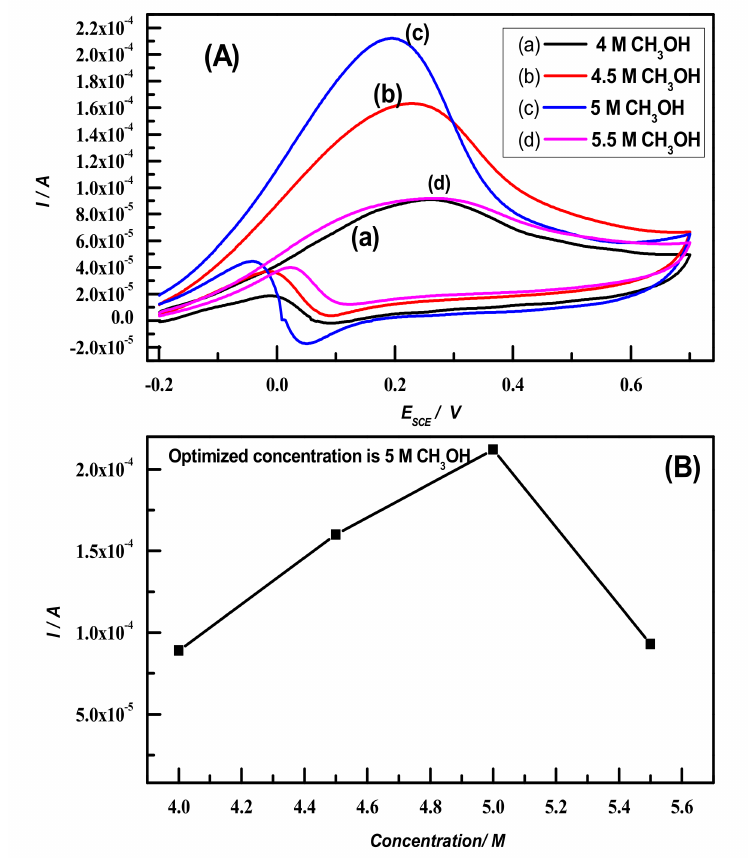
Figure 5. ( A ) CVs of PACHA coated electrodes recoded in different concentrations of methanol (as indicated) in 1.8 M NaOH at 50 mV/s; ( B ) effect of methanol concentration on anodic peak current density in 1.8 M